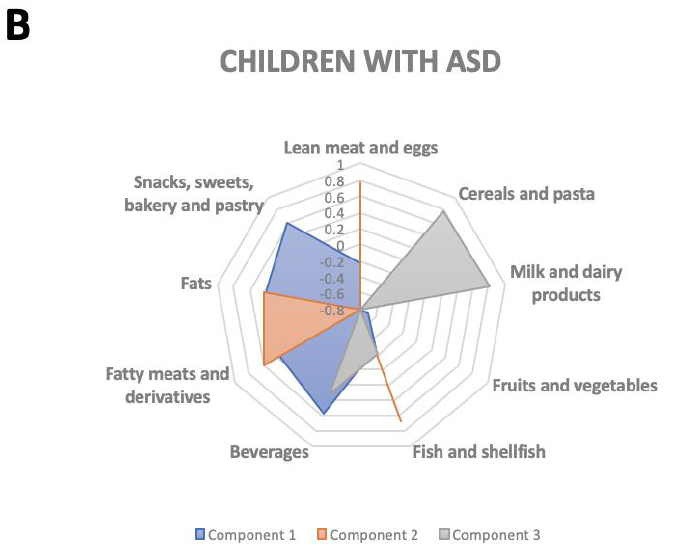
Figure 2. Dietary patterns extracted from the three-dimension principal component analysis of 9 major food groups. ( A ) Control group ( n = 57), ( B ) Children with ASD ( n = 54). Clusters of subjects classified based on their dietary characteristics are shown in a heat-map (Figure 3). There were two main clusters of children (columns) and three main dietary variables (rows) identified by the clustering algorithm. All ASD children, except- ing one subject, and all healthy children, were classified into two distinct clusters (blue for the ASD and red for the control population in Figure 3. Within the first food cluster, ASD